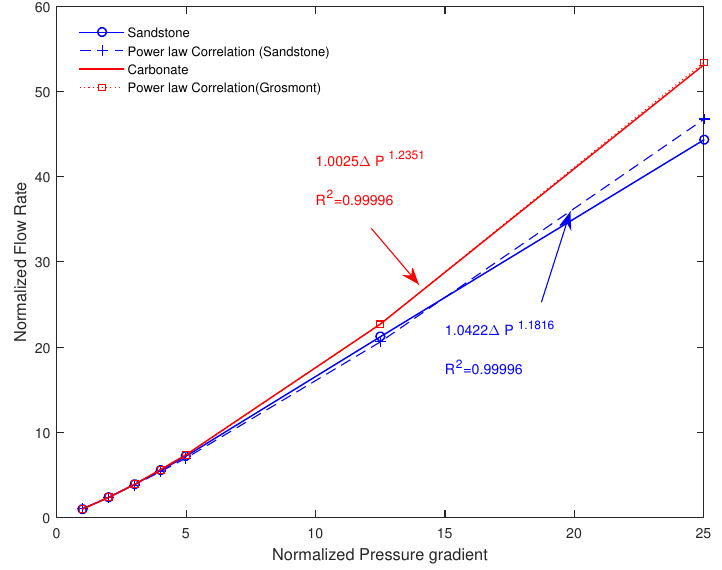
Figure 11. Simulated normalized flow rate and pressure gradient variation from pore-scale Simulated normalized flow rate and pressure gradient variation from pore-scale non-Newtonian model. non-Newtonian